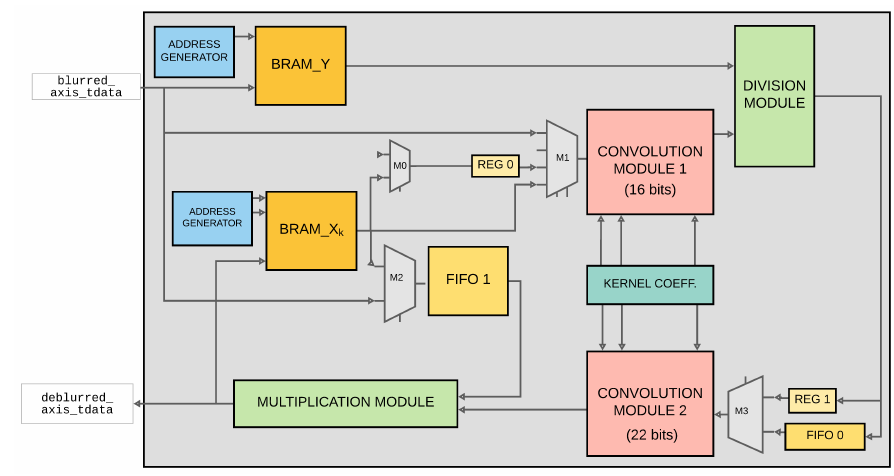
Figure 12. Complete block diagram for the RL deconvolution